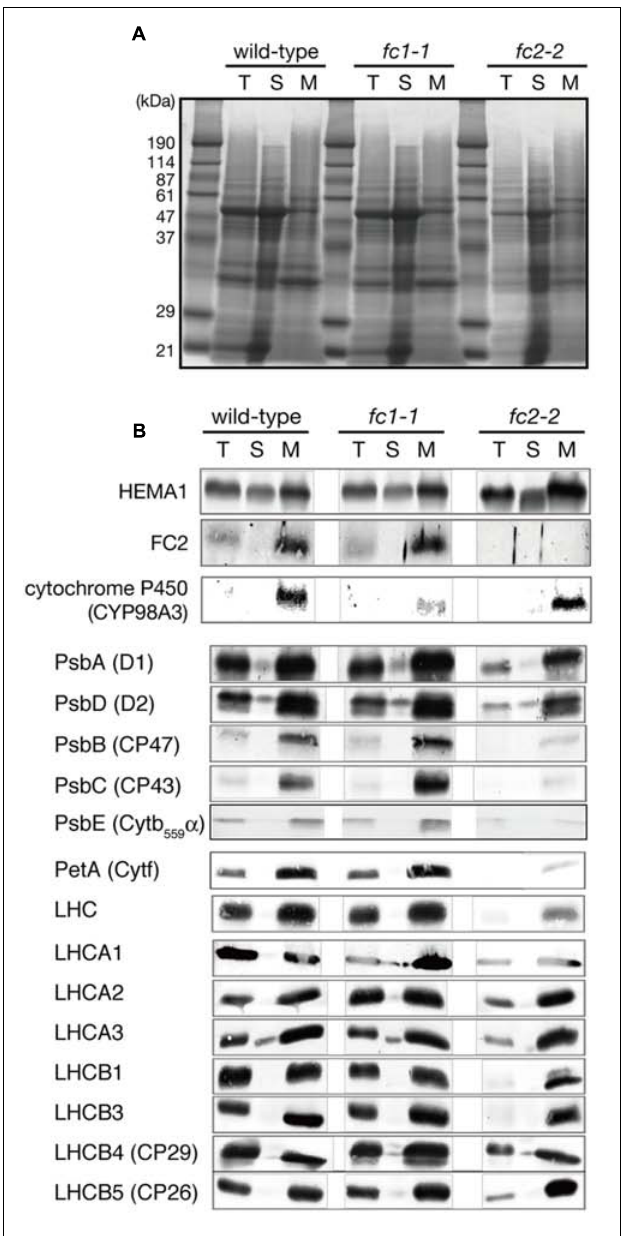
FIGURE 4 | Western blot analysis of heme-associated proteins and hemoproteins in ferrochelatase-deficient mutants. (A) CBB staining of SDS-PAGE. Samples of total (T), soluble (S), and membrane (M) fractions (40 µ g each) were loaded on the gel. (B) Western blot analysis of glutamyl-tRNA reductase (HEMA1), FC2, cytochrome proteins, core subunits of PSII complexes, and peripheral LHC proteins. Note that all cytochromes and FC2 were detected in membrane fraction, while HEMA1 was also detected in soluble fraction. “LHC” means polyclonal antibodies that recognize multiple LHC proteins were used for detection.